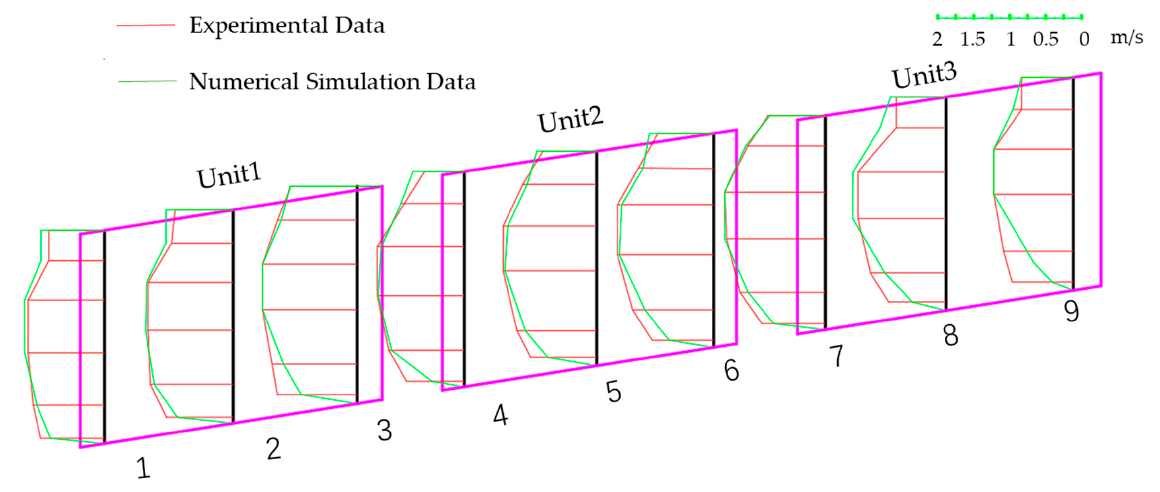
Figure 8. Axial velocity distribution diagram of inlet sump.